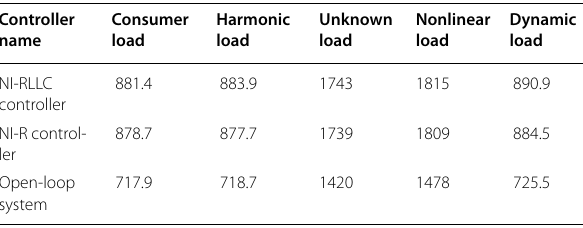
Table 9 Active power (watt) measurement for different loads of SISO